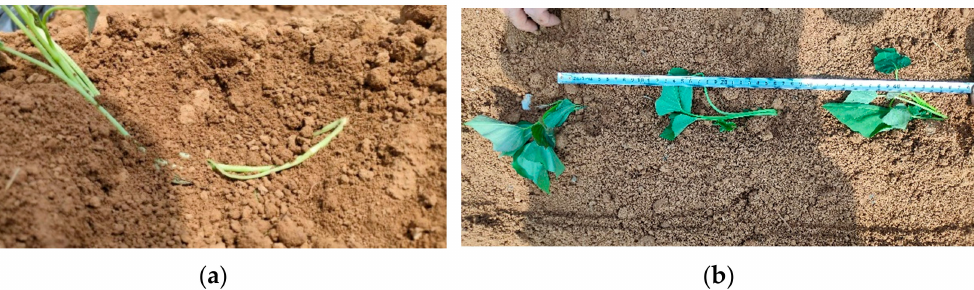
Figure 11. Transplanting renderings. ( a ) Boat-bottom-shaped transplanting, ( b ) plant spacing mea-